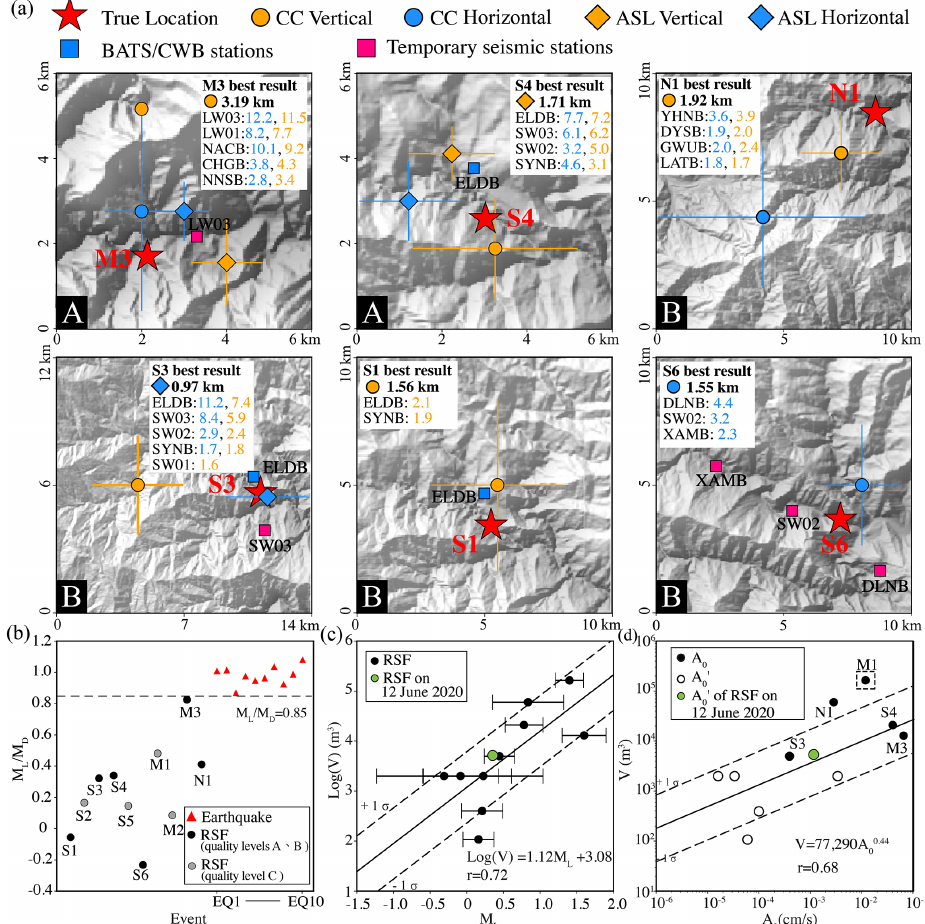
Figure 5. Results of the location process by the GeoLoc scheme, M L /M D of the RSFs and earthquakes, scaling of seismic parameters, and source volumes. (a) Results of location quality levels A and B from GeoLoc and their location uncertainties. The numbers beside the station names shown in the top-right corner are the SNR values for the horizontal (blue) and vertical (orange) envelopes. The symbol in the white box is the best location result, and the value beside the symbol indicates the location error. (b) M L /M D of RSFs and earthquakes; a horizontal dashed line indicates the M L /M D threshold of 0.85 used in this study. The relationships of (c) the event volume ( V ) and M L and (d) the event volume ( V ) and A 0 . The black circles show the A 0 extracted from the best location result. The open circles are the peak ground velocity ( A (cid:48) ), extracted from the nearest stations. Event M 1 is excluded from the regression analysis due to its high location error. The data 0 of the digital terrain model (DTM) of Taiwan are from the Government Open Data Platform,